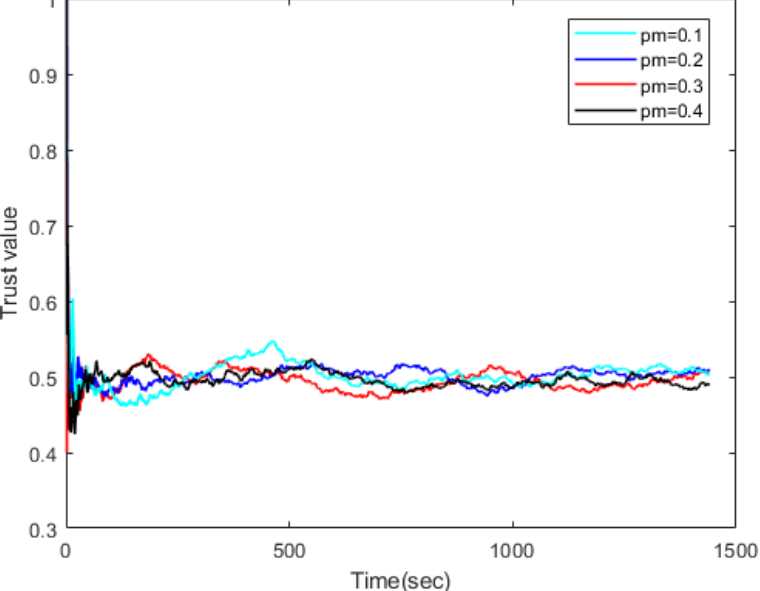
Figure 3. Trust value of a malicious node under adaptive control with pm ranging from 0.1 to